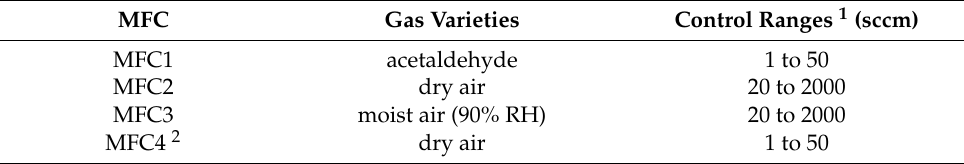
Table 1. MFCs controlled gas varieties, ranges, and accuracy. MFC Gas Varieties Control Ranges 1 (sccm)